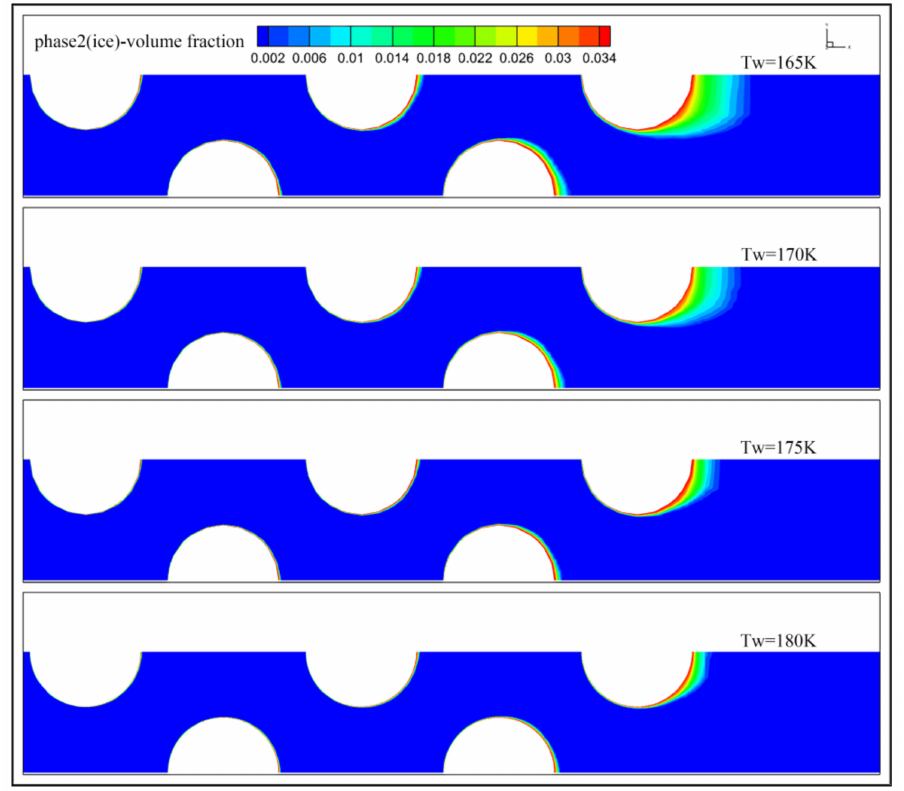
Figure 15. Frost morphology at different wall temperatures (5th